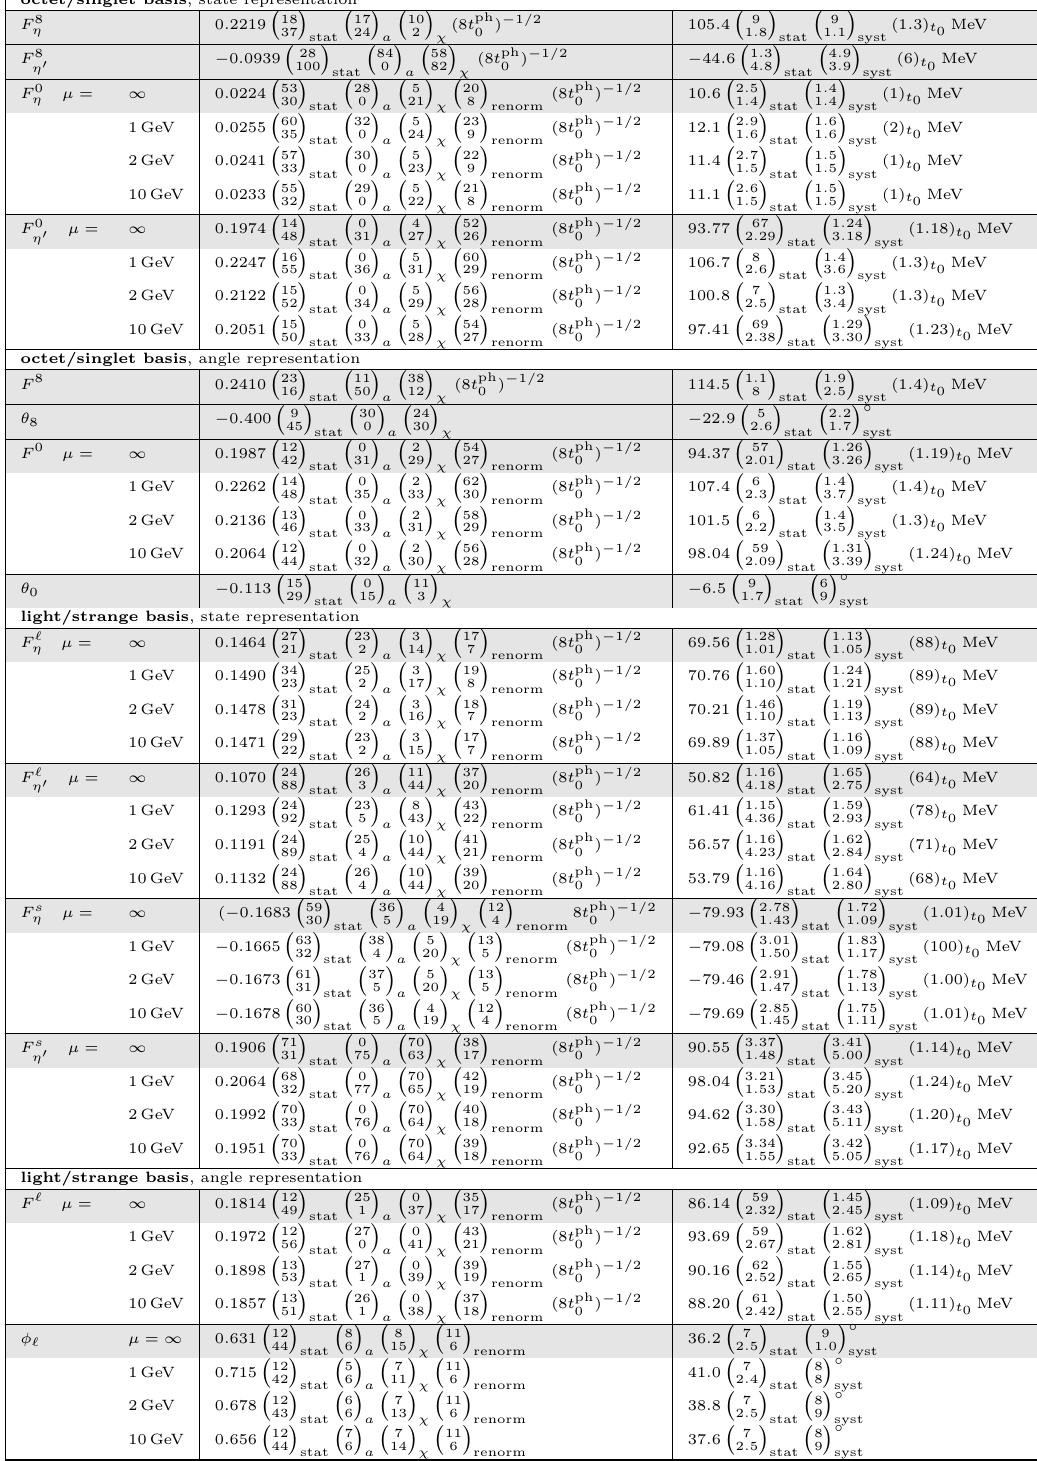
Table 24. Decay constants in various representations and at several renormalization